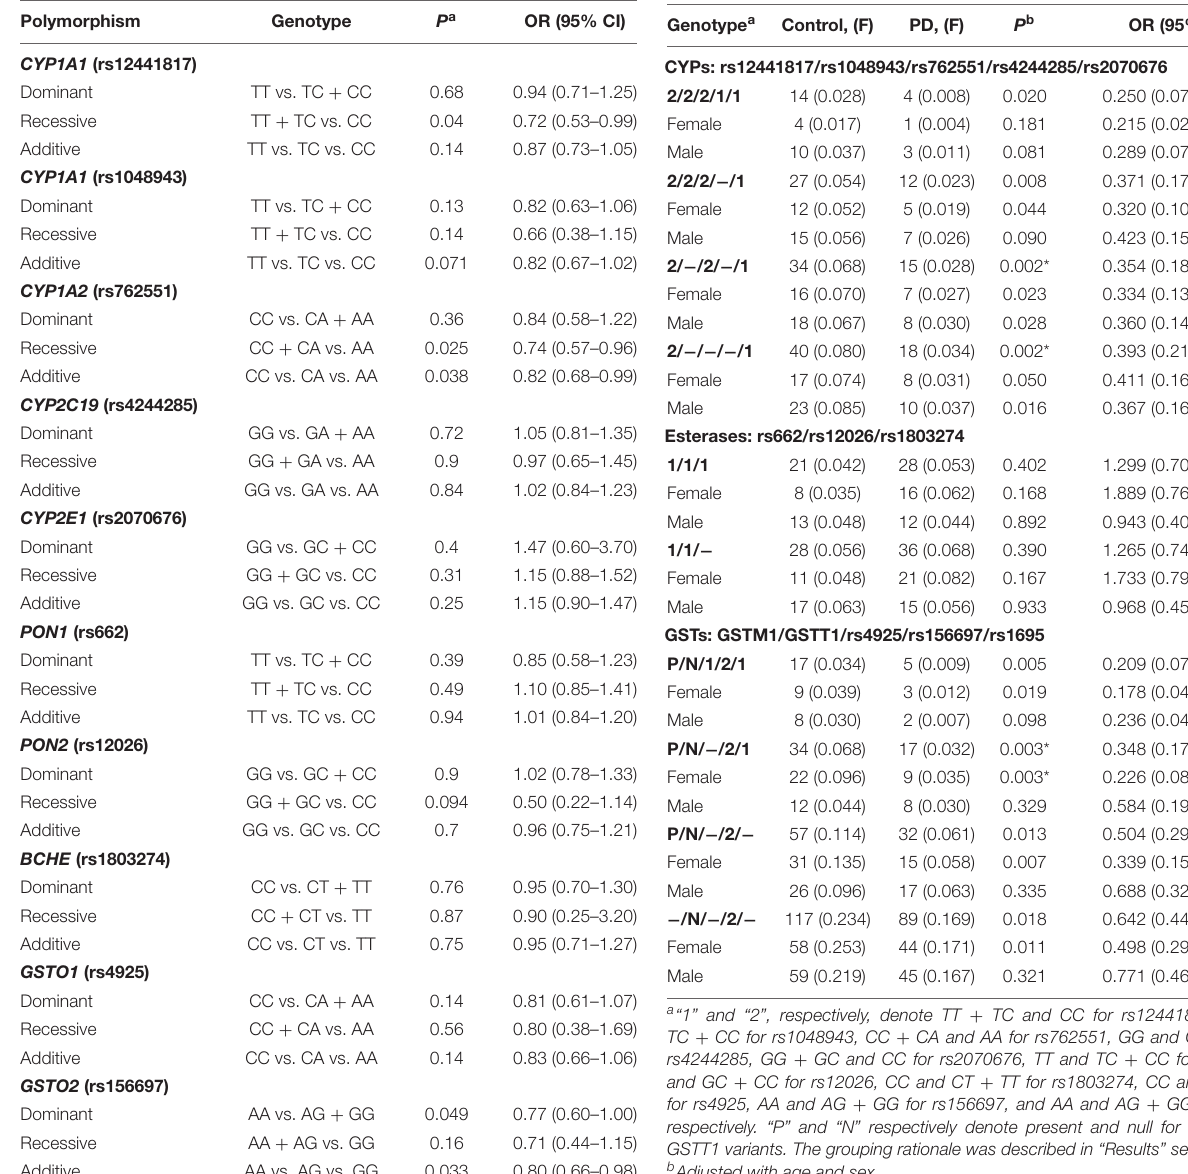
TABLE 3 | Interaction analyses of polymorphisms of CYPs, esterases and GSTs using backward elimination